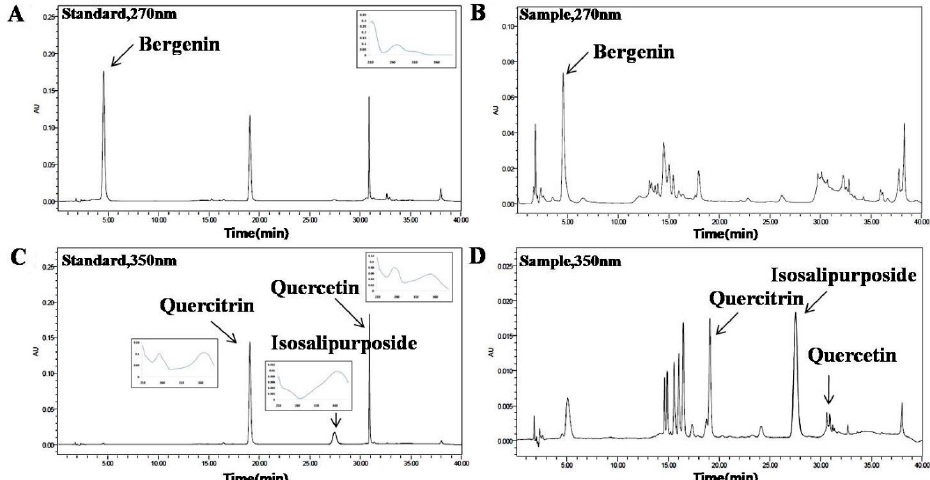
Figure 1. Identification of active compounds in C. coreana Uyeki flos by HPLC. ( A ) standard mixture at 270 nm; ( B ) sample extract at 270 nm; ( C ) standard mixture at 350 nm; ( D ) sample extract at 350 nm, A mobile phase consisting of mixture of solvent A (acetonitrile) and B (water containing 0.2%